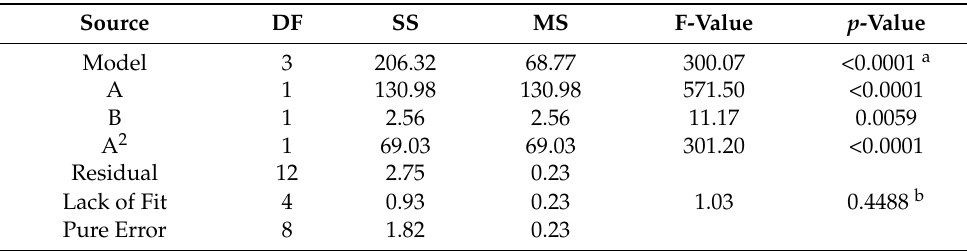
Table 3. ANOVA analysis for response surface second-order model. The considered responses are the efficiency of Zn extraction.